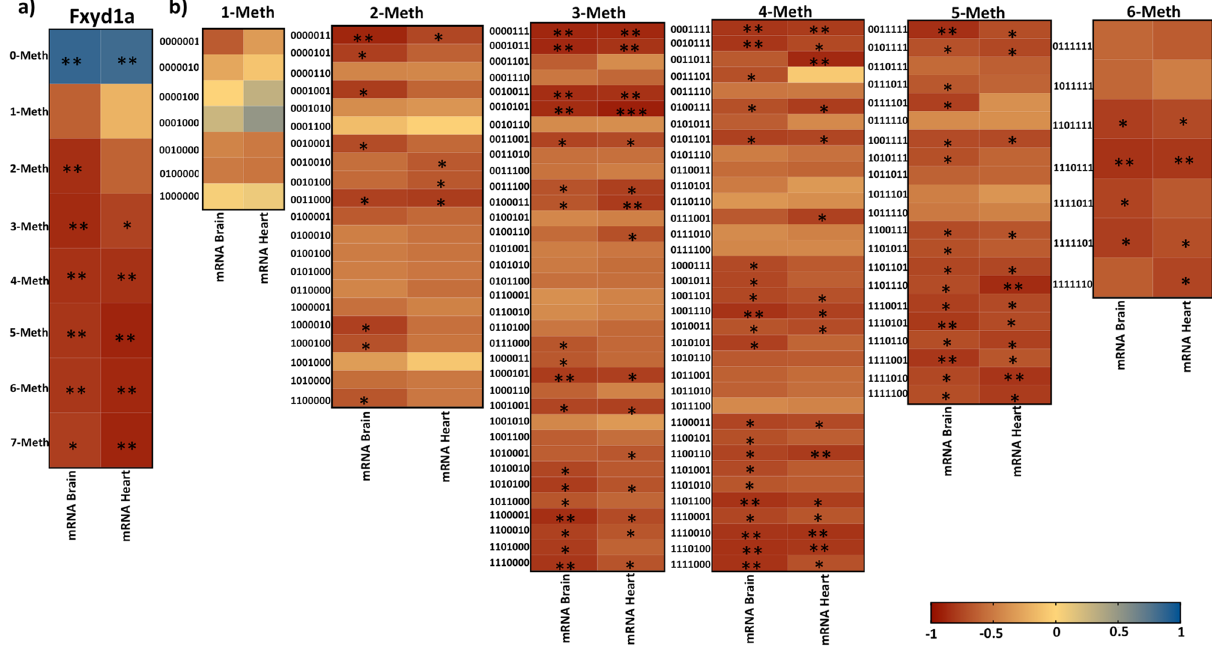
Figure 6. Correlation between epiallele classes and epiallele distribution with mRNA expression levels of Fxyd1a in brain and heart. ( a ) The graph reports r values derived from Pearson correlation between epiallele classes and mRNA expression of Fxyd1a, regardless of developmental time points. ( b ) Heatmaps of r values derived from Pearson correlation between epialleles and mRNA expression of Fxyd1a in brain and heart. Epialleles are shown as a string of numbers where 1 indicates methylated CpG sites and 0 indicates non- methylated CpG sites. The numbers of the strings correspond to the CpG sites analyzed in the Fxyd1a amplicon (shown in Fig. 2a) in the following order: − 118, − 91, − 47, − 3, + 92, + 112, + 131. The scale color from blue to red indicates a positive to negative correlation (− 1 ≤ r ≤ 1), respectively. Statistical analyses were performed using a Pearson correlation test (*p ≤ 0.05; **p ≤